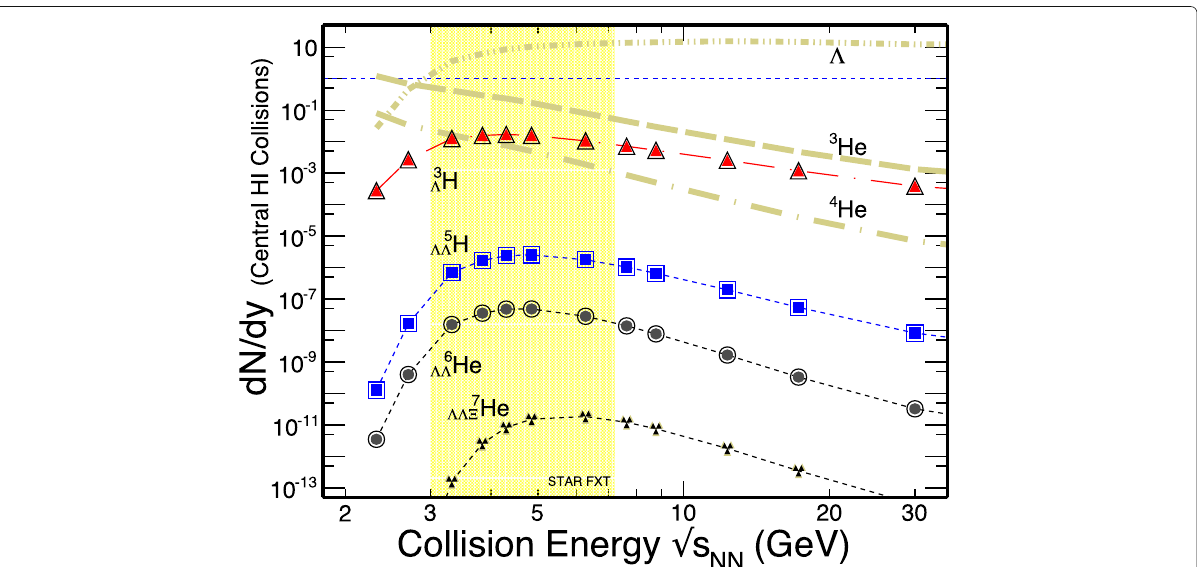
Fig. 6 Heavy nuclei (dashed lines) and (multi-)hypernuclei (symbols) yields calculated in the HRG model [70, 71] for central heavy-ion collisions at mid-rapidity as a function of center-of-mass energy. Also shown for comparison are the yields of (cid:2) hyperon from the same model. The collision energy region of fixed target program in STAR is indicated as a yellow band. Model results from Ref.